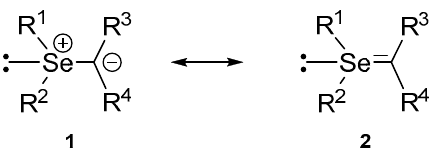
Figure 1. Resonance structures of selenonium ylides 1 and 2 .